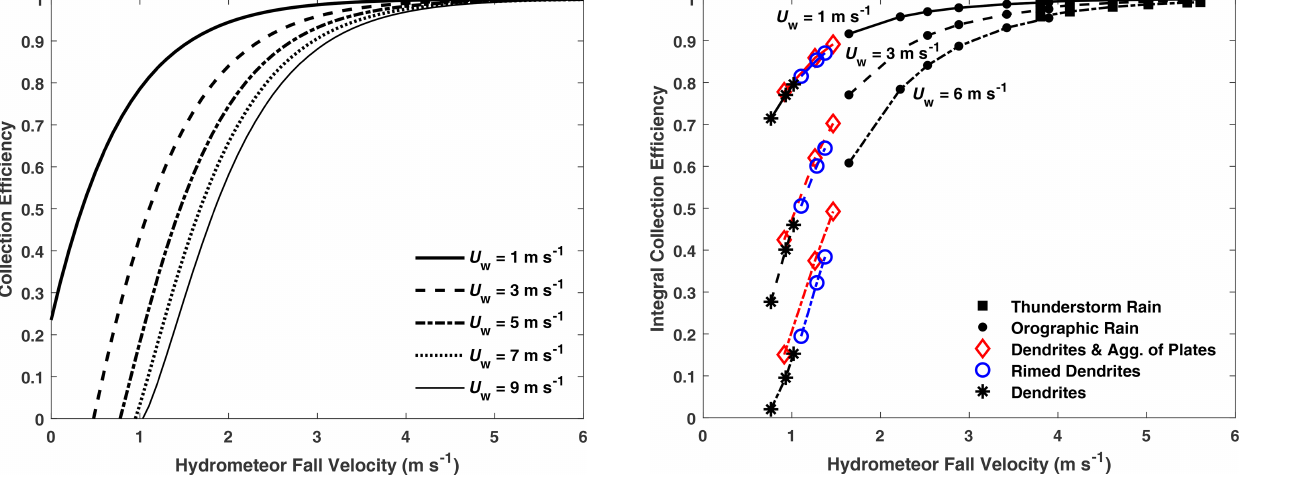
Figure 4. Geonor unshielded gauge collection efficiency for the ex- ponential fit model with hydrometeor fall velocity and wind speed.